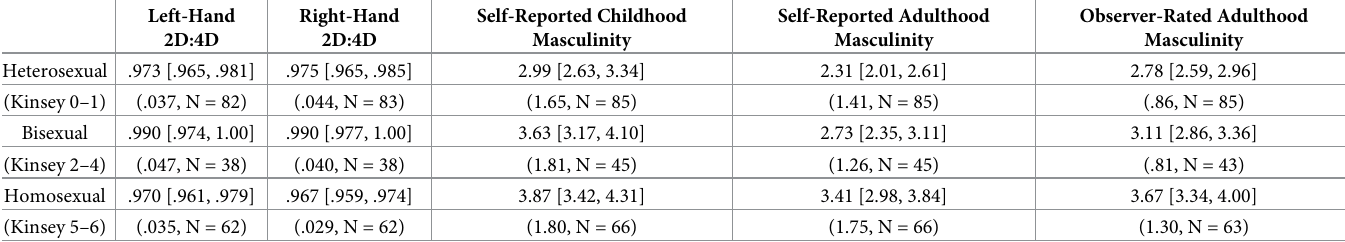
Note . Numbers in square brackets represent 95% confidence intervals of the mean. Numbers in round brackets represent standard deviations of the mean and sample sizes. For descriptive purposes, categorizations are based on the Kinsey sexual orientation score, with Kinsey 0–1 considered heterosexual, 2–4 considered bisexual, and 5–6 considered